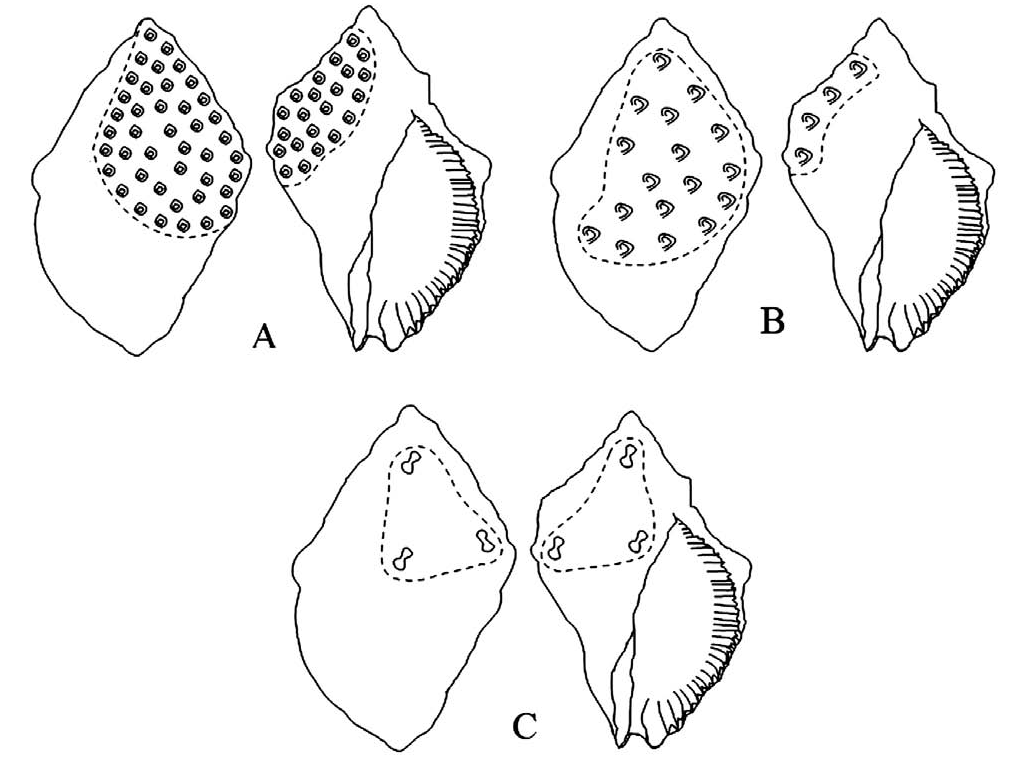
Fig. 3. – Preferential shell colonization zone/location of epibiotic species observed in the shells of heavily fouled S. haemastoma ; (A) barna- cles; (B) polychaete tubes; (C) perforations caused by Lithophaga aristata